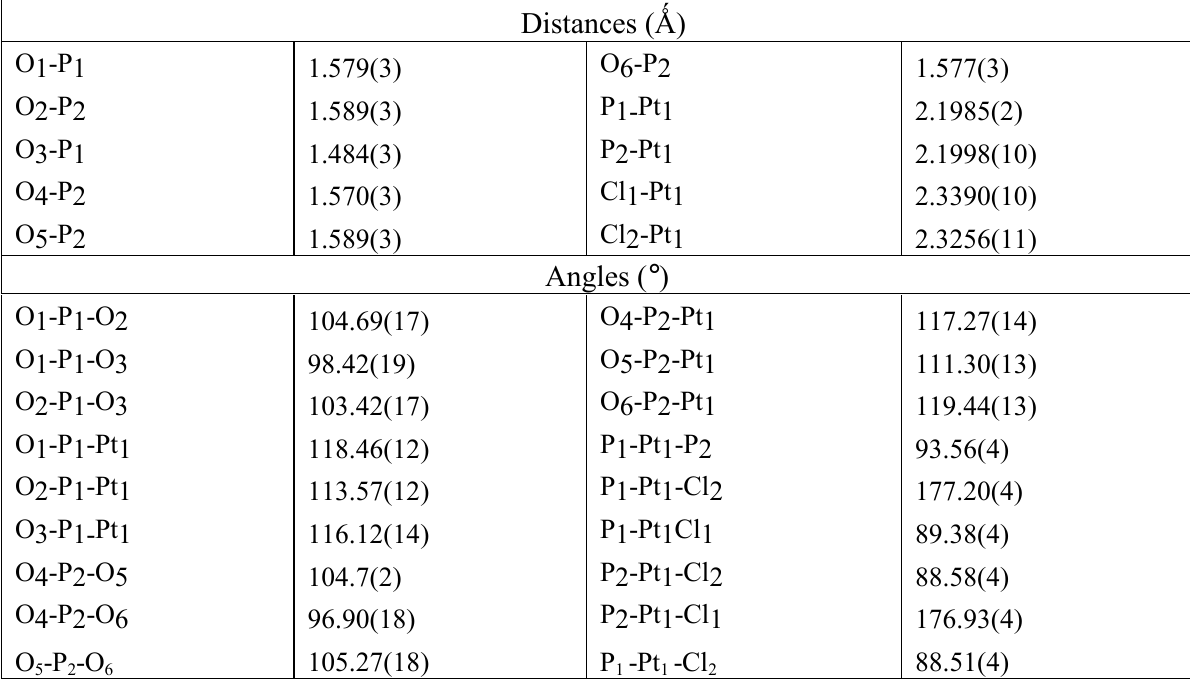
Table 2. Selected distances and angles for [PtCl2(P(OPh)